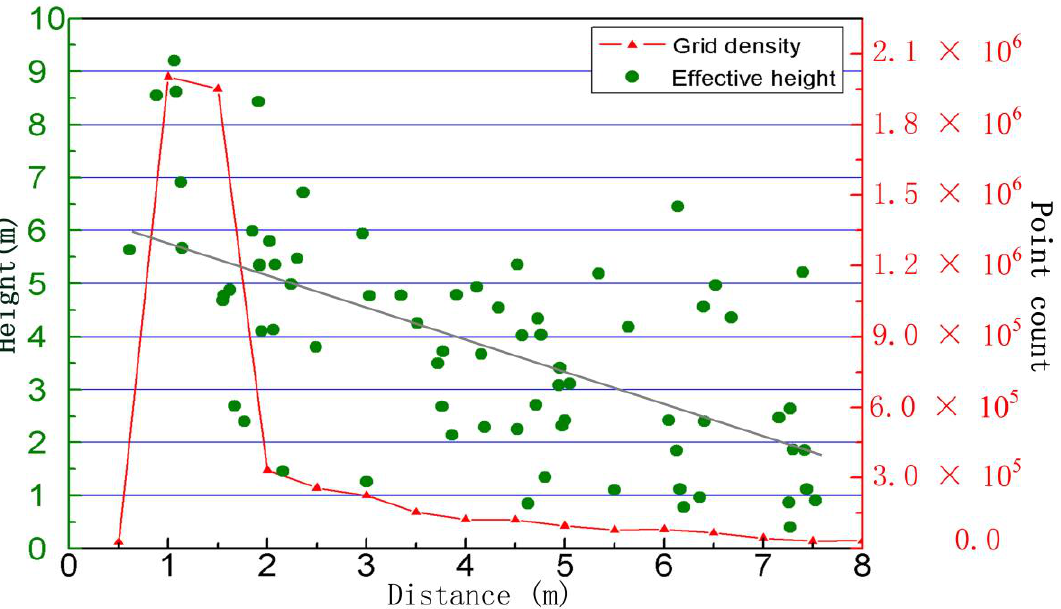
Figure 10. Point counts and change with distance in Plot A. The correlation coefficient between trend line and height data is